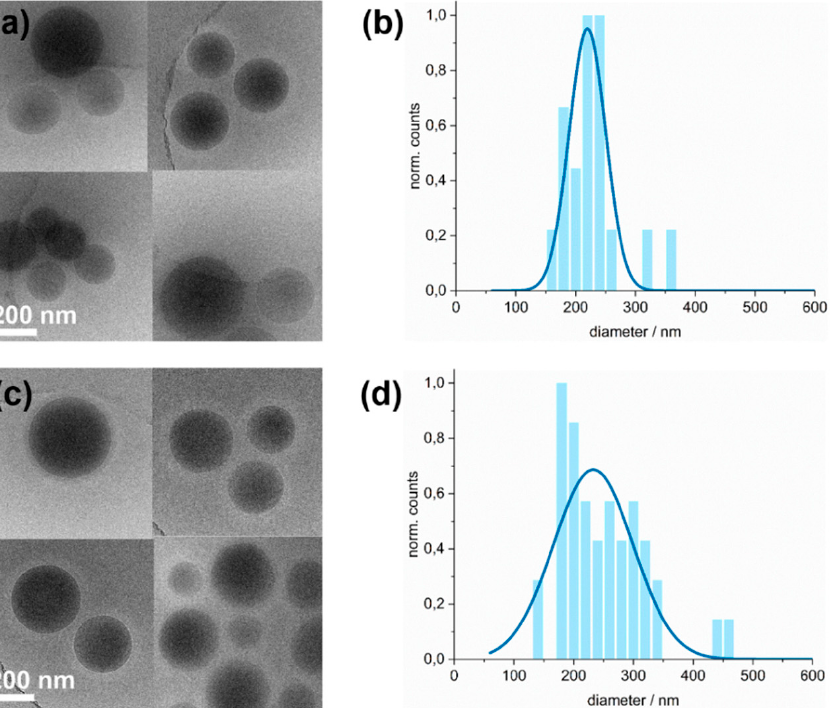
Figure 12. CryoTEM micrographs and evaluation of the particle size distributions of P(DMA 35 - NIPAM 212 )-PS 1089141 dispersions diluted with 0.5 M salt solutions to a final latex concentration of c = 0.2% ( w / w ). Due to the low contrast of the swollen corona against amorphous ice, only the dense micelle core is visible in the micrographs. ( a ) Exemplary cryoTEM micrographs of a P(DMA 35 - NIPAM 212 )-PS 1089141 dispersion diluted with an aqueous 0.5 M NaBr solution, ( b ) the histogram shows the size distribution of latex particles taken from analysis of cryoTEM micrographs of the sample exemplary shown in ( a ). A Gaussian fit (blue line) gave a mean diameter of 220 ± 61 nm; ( c ) Exemplary cryoTEM micrographs of a P(DMA 35 -NIPAM 212 )-PS 1089141 dispersion diluted with an aqueous 0.5 M NaSCN solution, ( d ) size distribution of latex particles taken from analysis of cryoTEM micrographs of the sample exemplary shown in ( c ). The histogram shows the size distribution of the micelles. The mean diameter of 233 ± 133 nm was determined by a Gaussian fit. For the analogous TEM micrographs at room temperature and size distributions of the samples diluted with the aqueous salt solutions, see Figure S4.